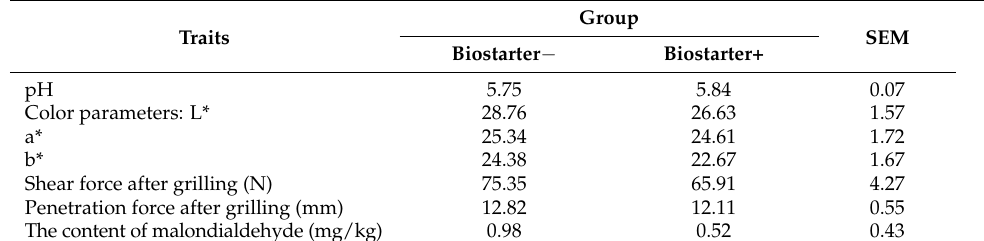
Figure 1. Weight loss of meat during dry-aging with and without biostarter. The orange and red shadows around lines stand for 95% confidence interval ; a, b, c—means marked with different let- ters differ significantly at p < 0.05.